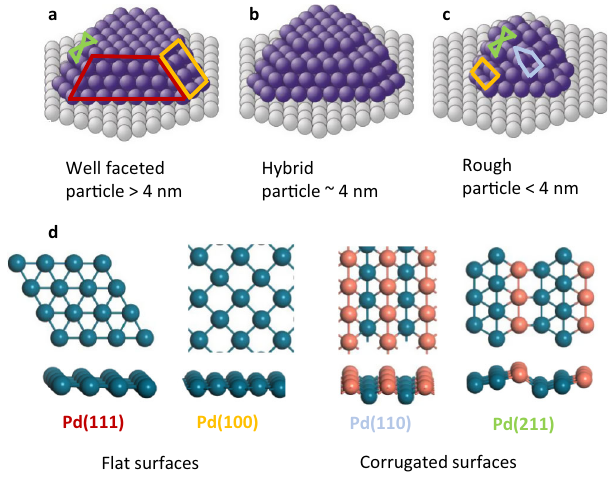
Fig. 2 Schematics of Pd nanoparticles as catalysts by combining smooth and stepped single crystal surfaces. a Large particles carry extended patches of smooth surfaces, modeled by selected facets. b “ Hybrid ” particle of larger size with rougher surface. c Smaller rough nanoparticle. d Ball and stick models of the smooth surfaces Pd(111) and Pd(100), and the rougher surfaces Pd(110) and